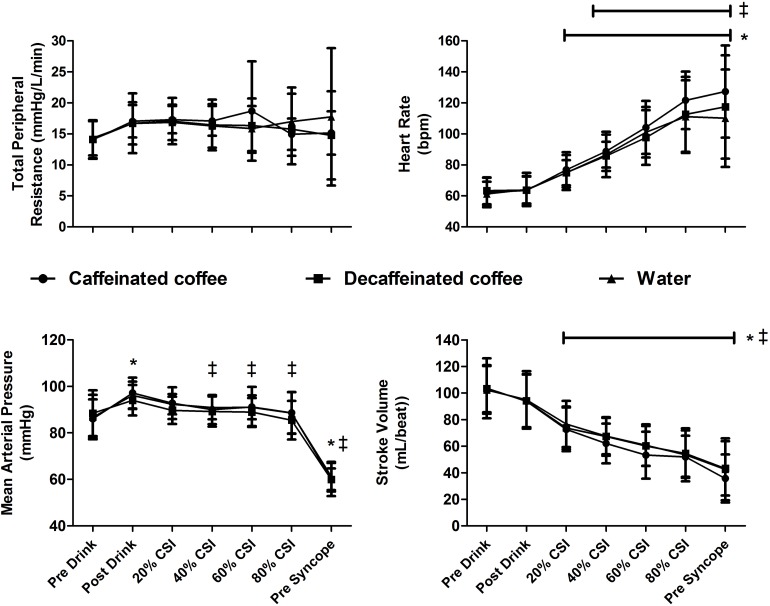
Cardiovascular responses to central hypovolemia. Stroke volume (SV), heart rate (HR), total peripheral resistance (TPR), and mean arterial pressure (MAP) responses are displayed at baseline (Pre Drink), after consumption of either caffeinated coffee, decaffeinated coffee or water (Post Drink), and throughout lower body negative pressure (LBNP). MAP was increased following consumption of all drinks and declined in all trials at pre syncope. HR increased and SV decreased in all trials throughout LBNP relative to pre drink values. Data are displayed as mean ± standard deviation for thirteen participants. *different from baseline in all trials (P < 0.05). ‡ different from Post Drink values in all trials (P < 0.05).